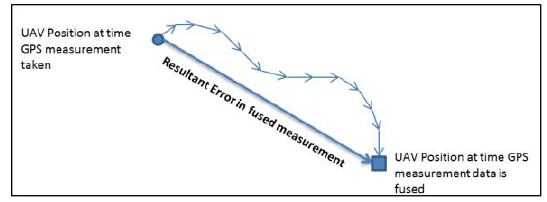
Figure 1 - Effect of delayed position measurements in